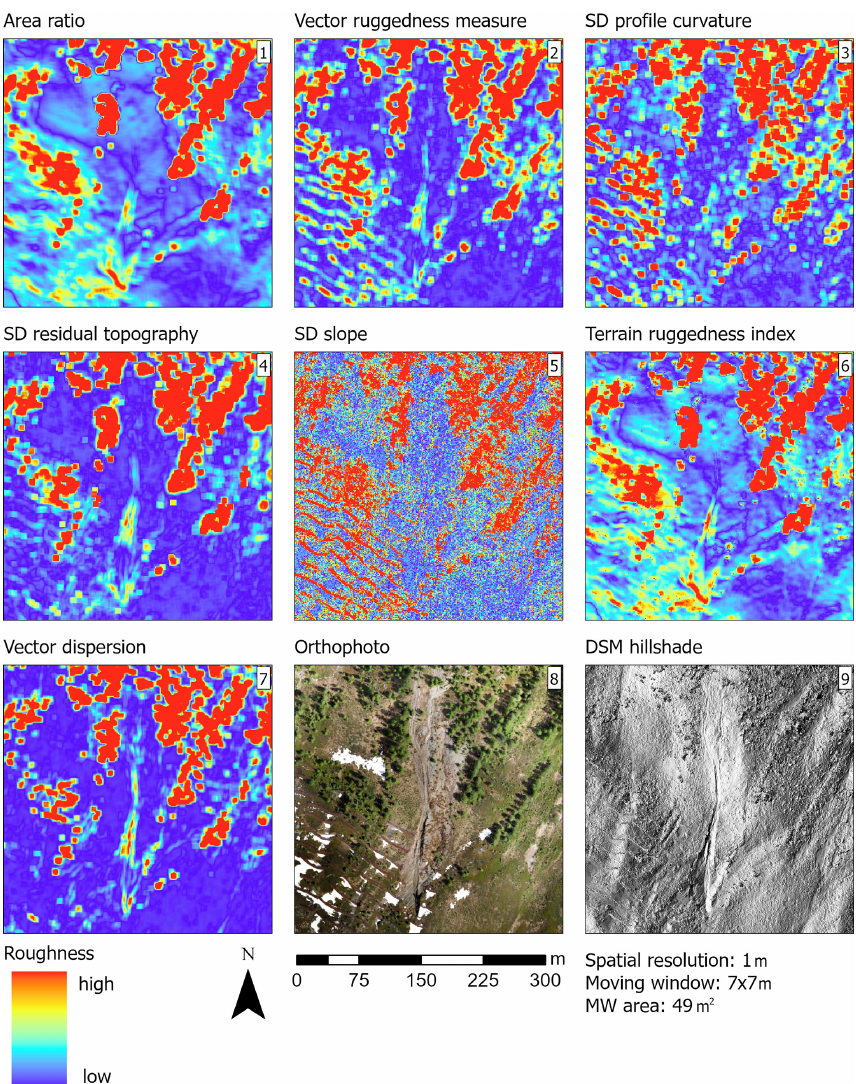
Figure 5. Calculated surface roughness in the study area Braema using the seven investigated algorithms: area ratio (1) , vector ruggedness measure (2) , SD of profile curvature (3) , SD of residual topography (4) , SD of slope (5) , terrain ruggedness index (6) and vector dispersion (7) . The same area is presented as an orthophoto (8) (drone flight, 2019) and in DSM hillshade (9) (© swisstopo). All algorithms were calculated based on the overall best performing combination of spatial resolution (1m) and neighbourhood (moving window 7 × 7m). To improve the visualisation and compare the roughness maps, we normalised them with the 25th percentile as the minimum value and the 75th percentile as the maximum